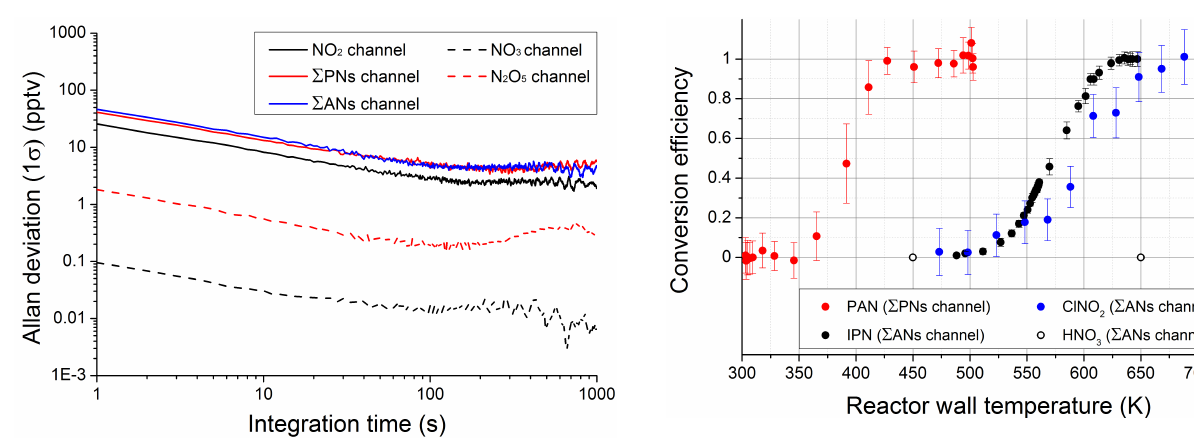
Figure 4. Decomposition profiles of PAN (red points), i-propyl ni- trate (black points) and ClNO 2 (blue points) with statistical errors (1 σ ). The PAN decomposition profile was measured in the (cid:54) PNs channel; the i-propyl nitrate (IPN) and ClNO 2 profile were mea- sured in the (cid:54) ANs channel. The open black circles indicate the lack of HNO 3 decomposition when sampled into the (cid:54) ANs